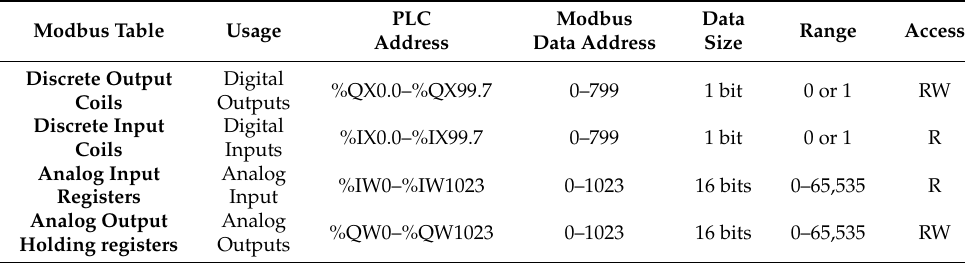
Figure 9. Sequence diagram for the first case study. Table 1. Modbus server variables in OpenPLC engine